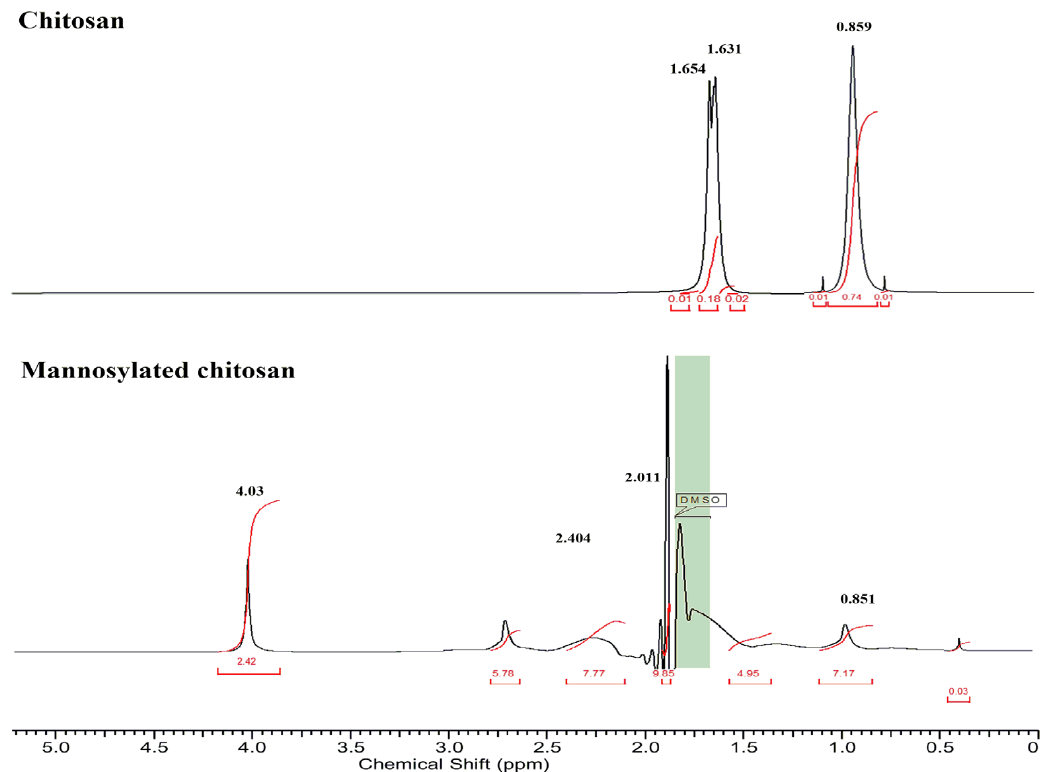
Figure 2. NMR spectra of chitosan and mannosylated chitosan. The respective chemical shift peak signals are mentioned in bold. The red text presents the integral (or area) of the peak signals.